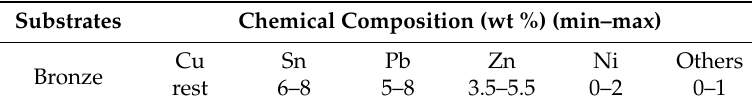
Table 2. Chemical composition of the bronze substrates.